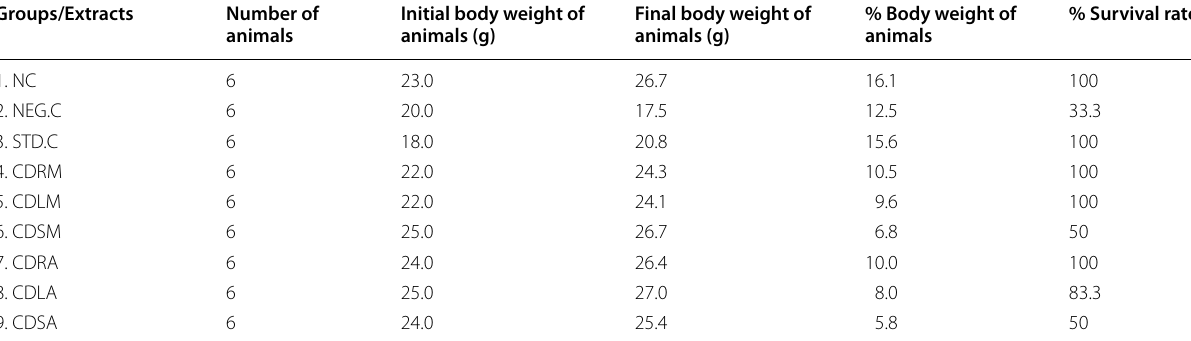
NC, normal control; NEG.C, negative control; STD.C, standard control; CDRM, C. dependens root methanol; CDLM, C. dependens leaves methanol; CDSM, C. dependens stem methanol; CDRA, C. dependens root aqueous; CDLA, C. dependens leaves aqueous; CDSA, C. dependens stem aqueous